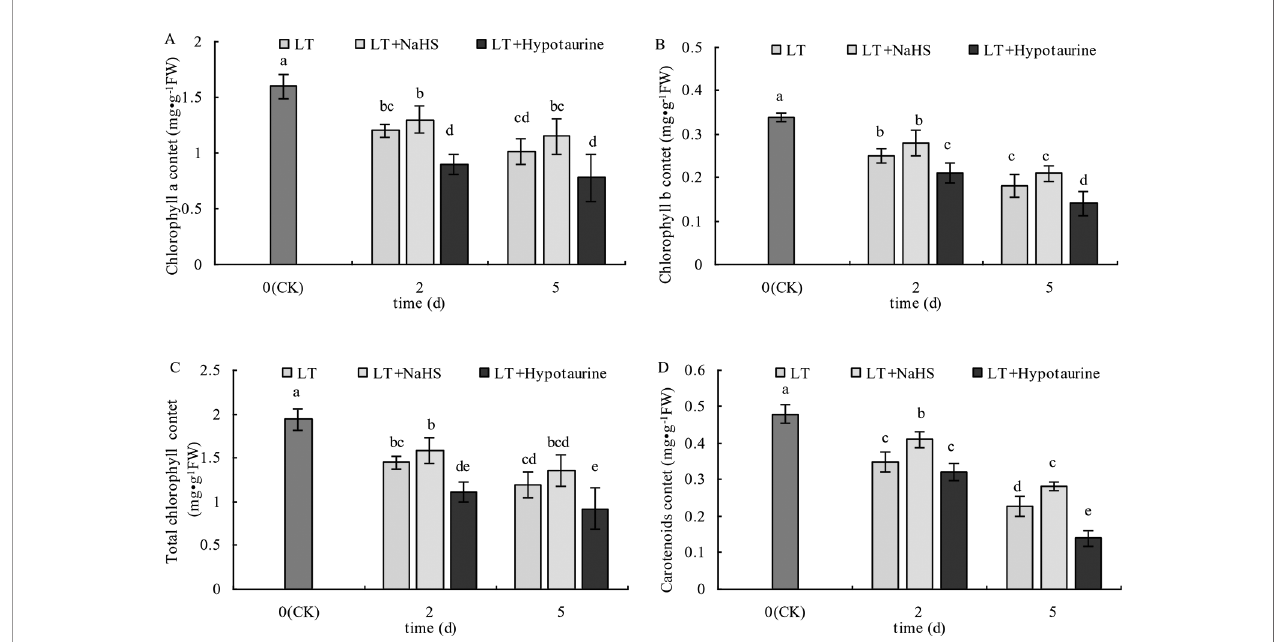
FIGURE 1 | Effects of exogenous NaHS and Hypotaurine on chlorophyll a (A) , chlorophyll b (B) , total chlorophyll a (C) , and carotenoid (D) contents in blueberry leaves under low temperature stress. The data in the fi gure are from three replicated experiments (n = 3), and represent means ± standard error (SE). Different small letters show signi fi cant differences ( P < 0.05). CK: room temperature control at 25°C; LT: low temperature treatment; LT + NaHS: low temperature treatment at 4 – 6°C after spraying 0.5 mmol·L – 1 NaHS; LT + Hypotaurine: low temperature treatment at 4-6°C after spraying leaves with 200 m mol·L – 1